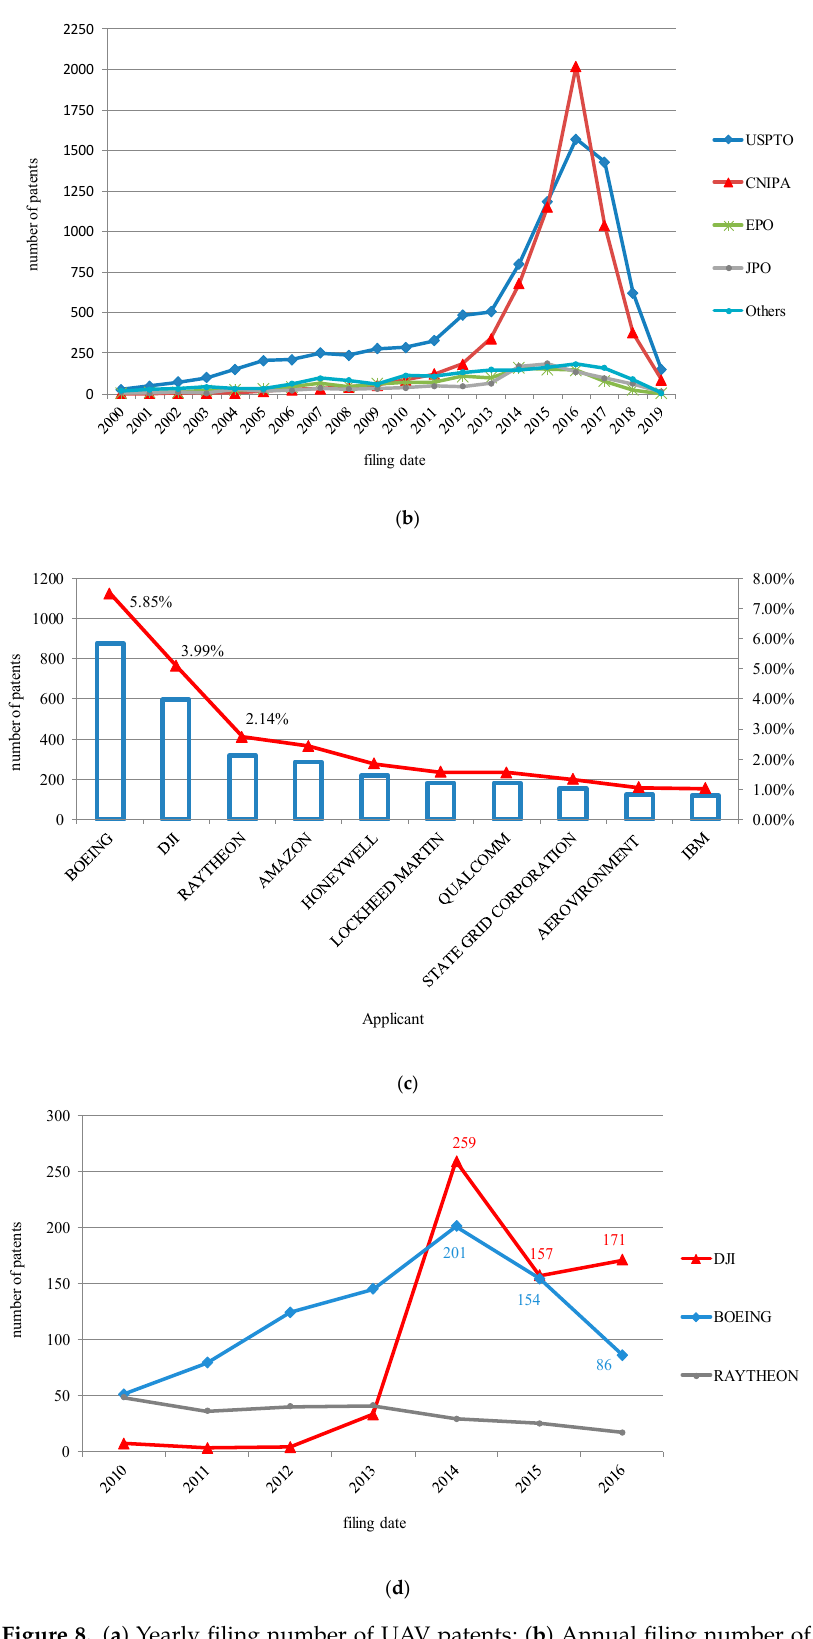
Figure 8. ( a ) Yearly filing number of UAV patents; ( b ) Annual filing number of UAV patents for different geographical authorities; ( c ) Total number and share of patents granted to and owned by the top ten companies; ( d ) Yearly filing number of patents applied for by DJI, BOEING, and RAYTHEON.